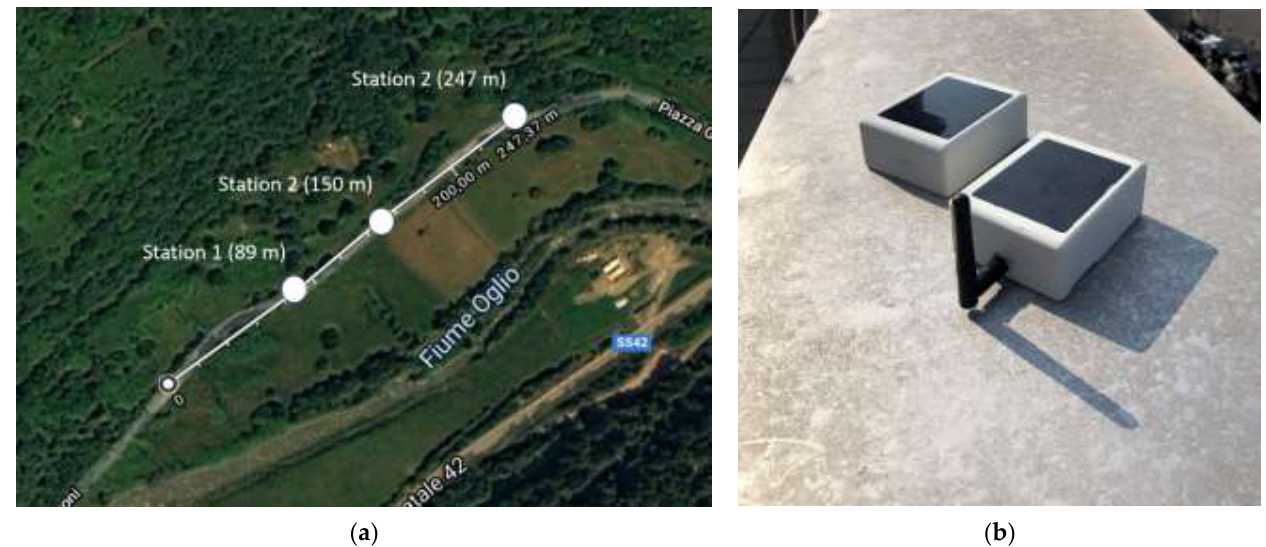
Figure 10. Communication range test in countryside scenario: ( a ) Map of the test area and ( b ) WindNode endowed of the external antenna.